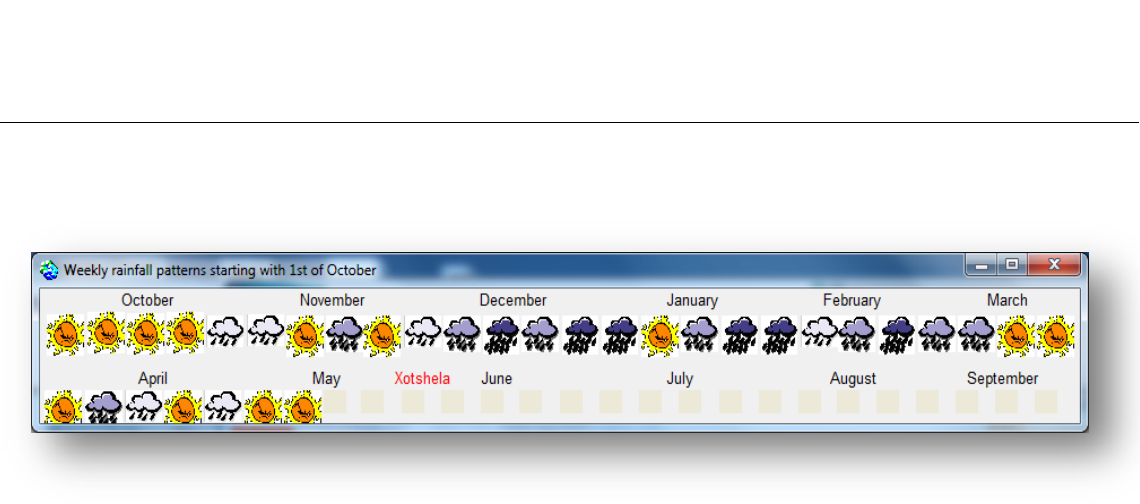
Figure 5. The weekly rainfall calendar. The sun corresponds to a dry week, a light cloud represents 5-20mm of rain, a grey cloud represents 20-40mm of rain, the dark cloud represents +40mm of rainfall. The first of June is indicated as xotshela , a Ndebele word meaning “to push”, that corresponds to the historical traditional date when cattle are released freely in the fields to eat the crops